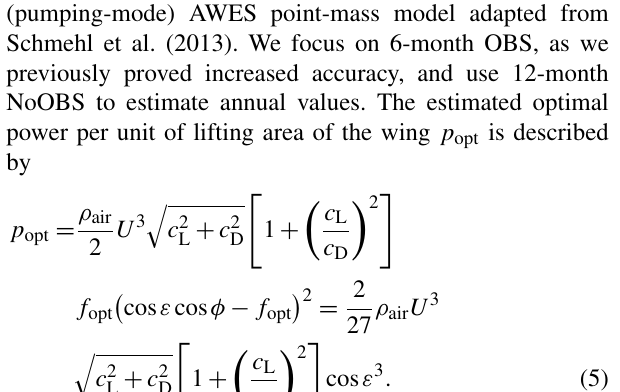
Figure 10. Frequency of optimal traction power over optimal oper- ating altitude based on 6-month OBS (a) and 12-month NoOBS (b) assuming a constant tether length of 1500m. The continuous white line shows the frequency of optimal operating altitude for the whole power range (abscissa axis in a